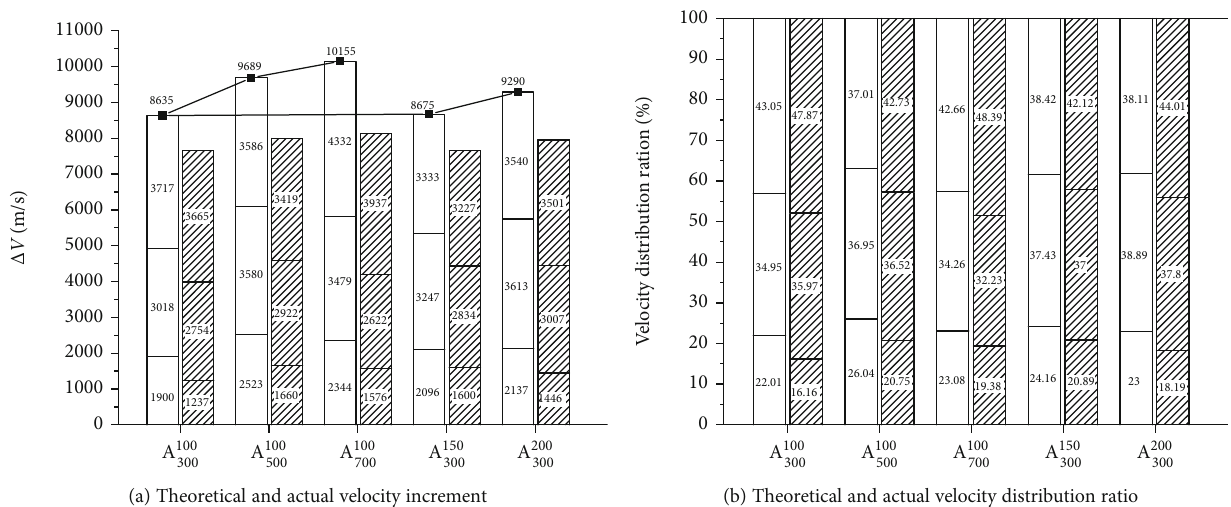
Figure 16: Velocity increment and velocity distribution ratio: (a) theoretical and actual velocity increment; (b) theoretical and actual velocity distribution